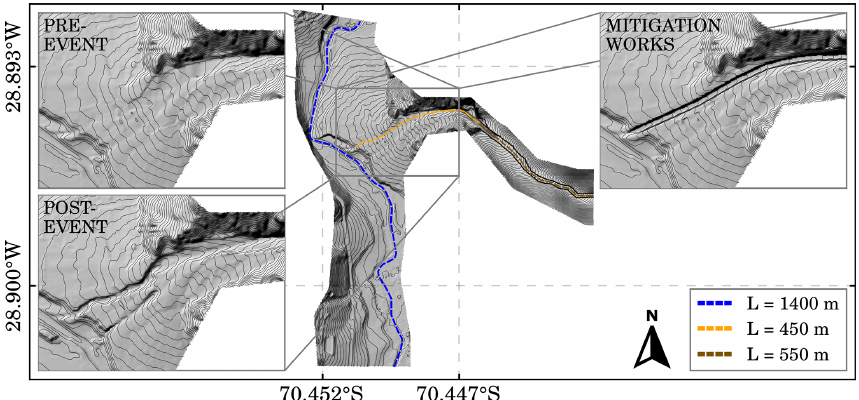
Figure 3. Topographic data modifications. Post-event topography corresponds to the available lidar topography while the pre-event topog- raphy is a restitution based on satellite images and the available topography. The synthetic channel (dashed brown line) attached to the lidar topography is 550m long, while feeder channel (dashed orange line) is 450m long. In the post-event topography, the feeder channel is the result of the inertial debris flow incisions on the alluvial fan. In the mitigation works’ topography, the feeder channel was replaced by a straight rectangular